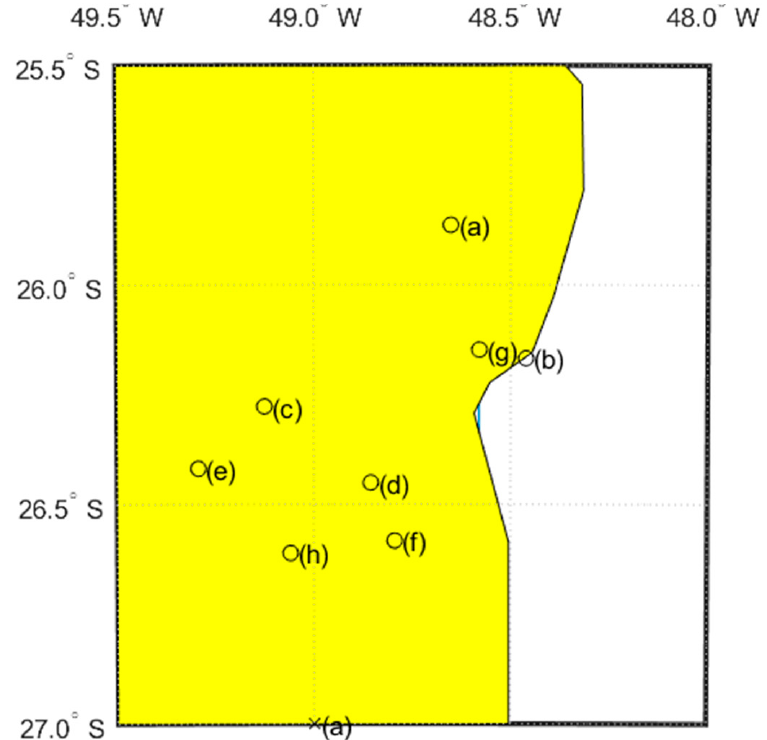
Figure 8. Development of the SAA maximum and centroid.